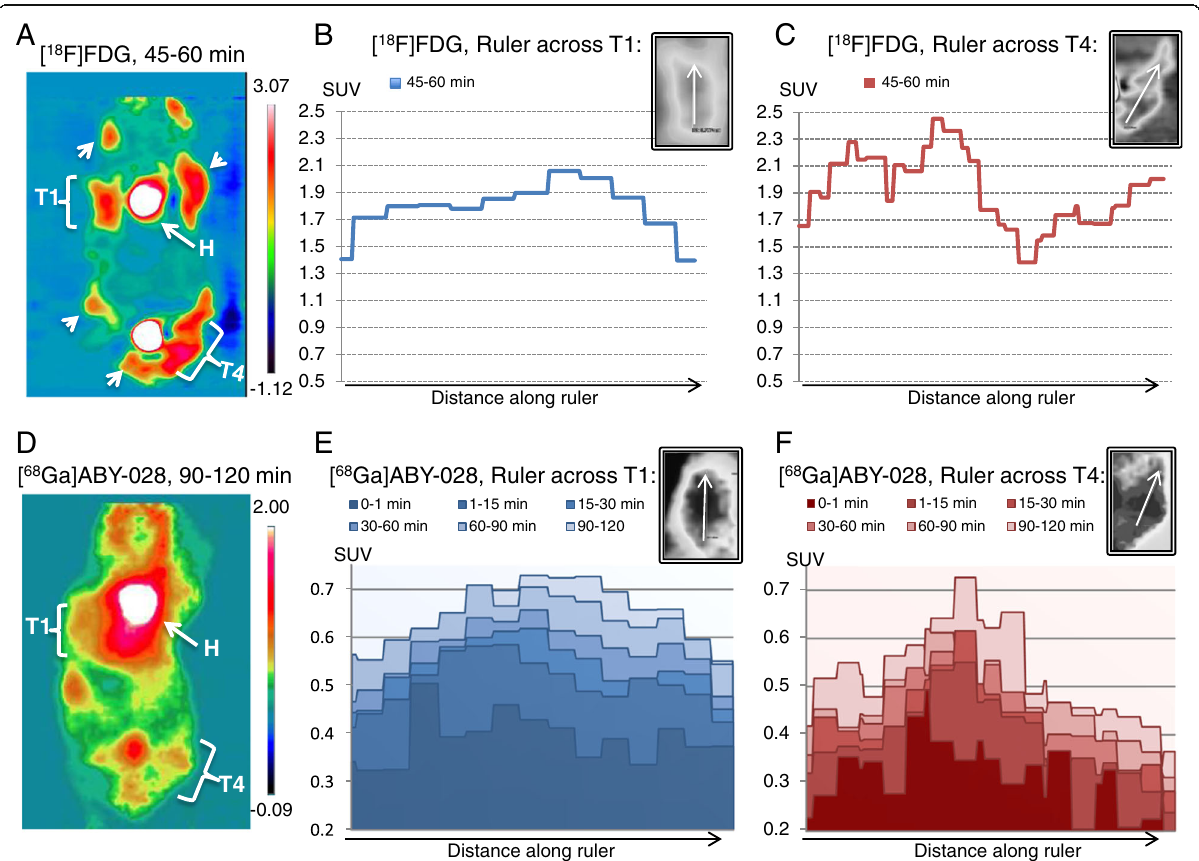
Fig. 6 Comparison of metabolism and permeability in a MMTV-PyMT mouse with multiple mammary tumors, two of these depicted here by the brackets and as T1 and T4, arrowheads showing other tumors. a , d Coronal PET images of the radioactivity uptake after i.v. injection of [ 18 F]FDG and [ 68 Ga]ABY-028, respectively. The different scales of the SUVs in the images are shown in the color bars to the right of each image. b , c , e , f Profiles of radioactivity concentrations along a ruler placed at one position (placements shown in the gray inserts above each graph) in T1 and T4. Only one graph for [ 18 F]FDG uptake is shown in b (T1) and c (T2) since the peaks and profiles did not change appreciably after the early uptake phase. With [ 68 Ga]ABY-028 in e and f the 0 – 1 min profile indicated the vascular radioactivity while the subsequent profiles visualized the changes in the degree and local heterogeneity of the leakage of the albumin-bound radioactivity into parts of the tumors over